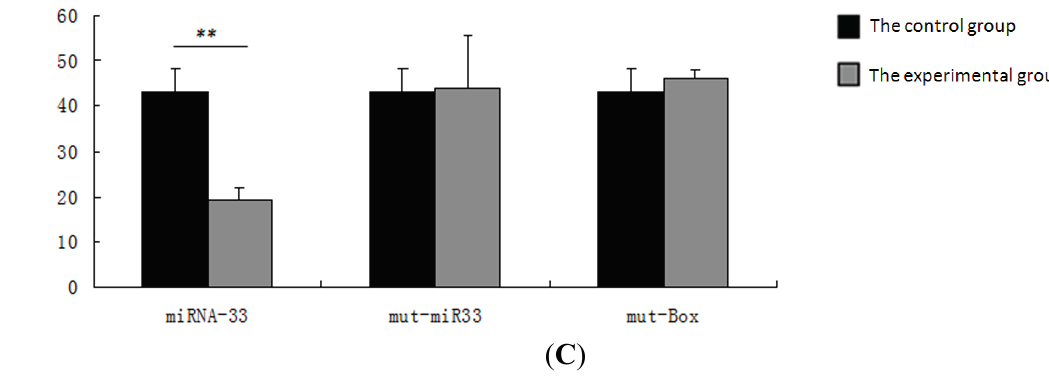
Figure 6. Detection of luciferase activity after target site mutation. ( A ) Luciferase activity after target site mutation in the CROT gene; ( B ) luciferase activity after target site mutation in the HADHB gene; ( C ) luciferase activity after target site mutation in the NPC1 gene. Control group: pcDNA3.1 + pmiR-report + phRL-TK; miRNA-33: pcDNA3.1-miR-33 + pmiR-report + phRL-TK; mut-miR-33: pcDNA3.1-mut-miR-33 + pmiR-report + phRL-TK; mut-Box: pcDNA3.1-miR-33 + mut-pmir-report + phRL-TK. Mut is an abbreviation of the mutant gene. Mut-miR-33 represents the mutation of miR-33, and mut-box represents the mutation of target sites. * represents p < 0.05; ** represents p <